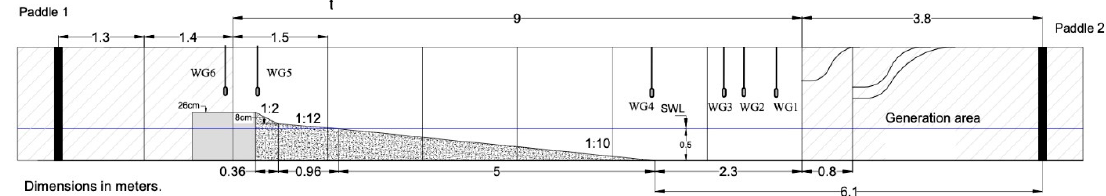
Figure 2. Scheme of the wave flume and the model (case of water depth 0.50 m).